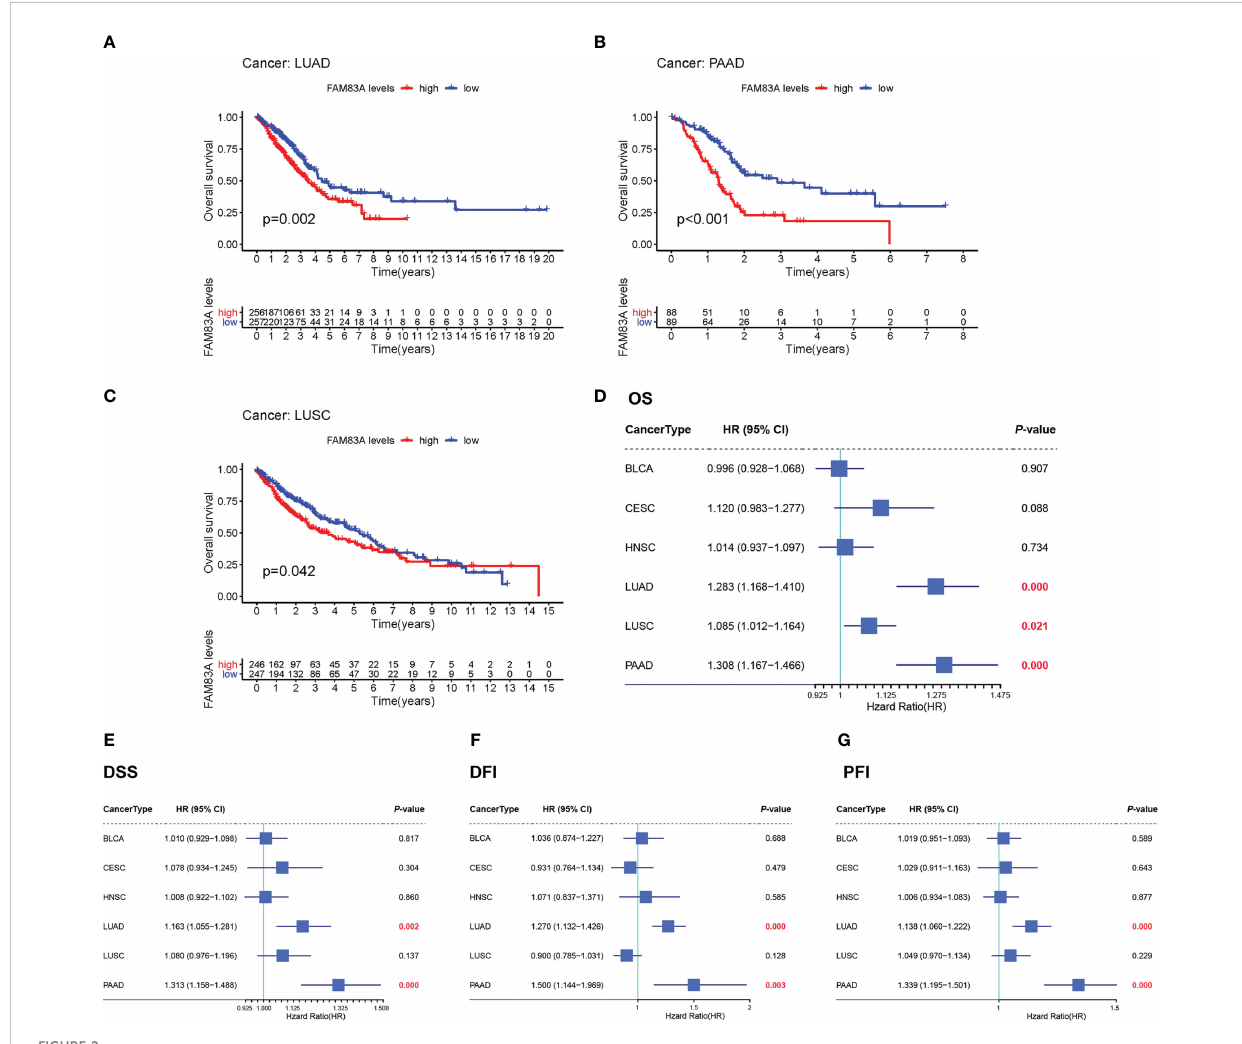
FIGURE 2 The overall survival (OS) and univariate Cox regression analysis for FAM83A in 6 human cancers based on TCGA: (A – C) The OS plot of FAM83A in LUAD (A) , PAAD (B) , LUSC (C) . (D) the OS forest plot. (E) the DSS forest plot. (F) the DFI forest plot. (G) the PFI forest